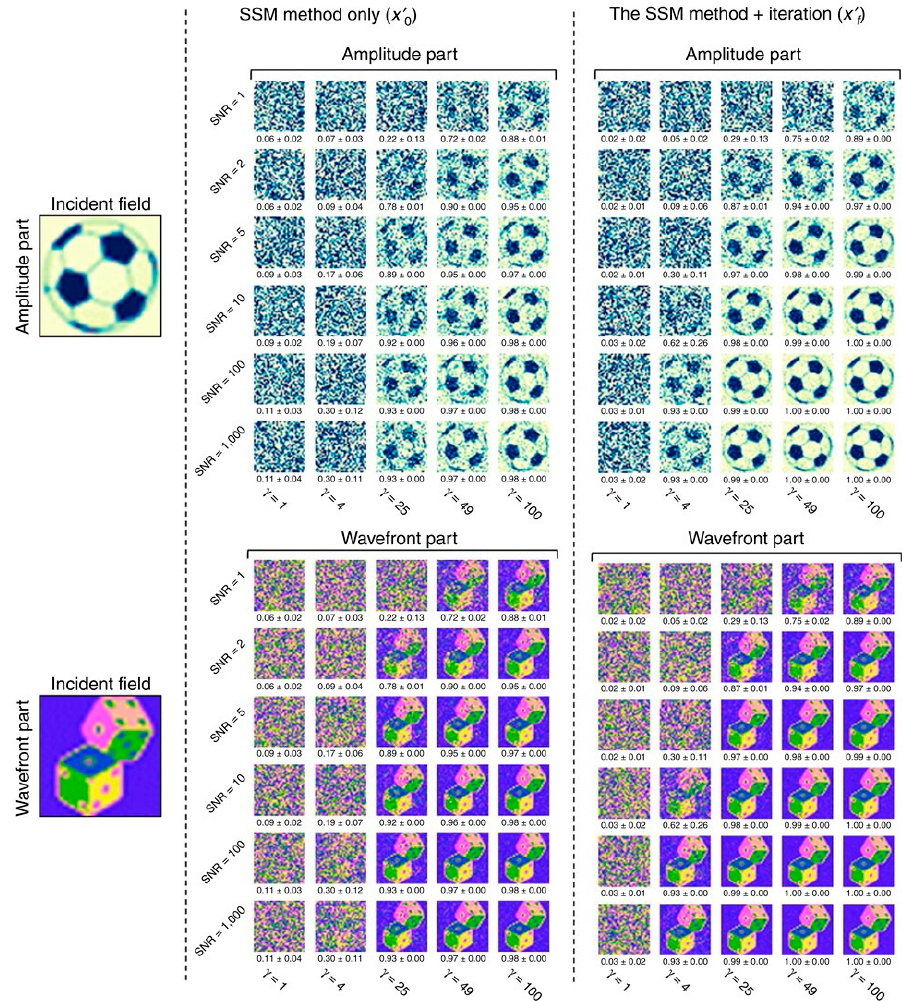
Figure 9. Amplitude and phase images before and after the error-reduction algorithm for the SSM with rank 1. Adapted from [36], CC-BY-4.0. SNR, signal-to-noise ratio.